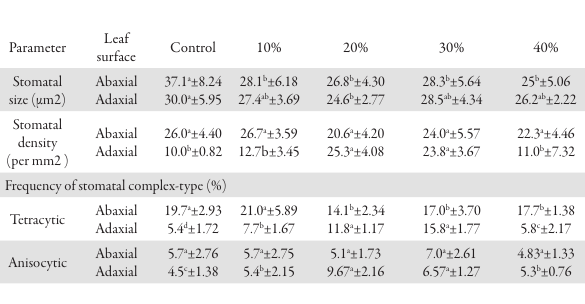
Fig. 2. Epidermal leaf structures of A. hybridus irrigated with pharmaceutical effluent; (A) trichome density and (B) number of epidermal cells